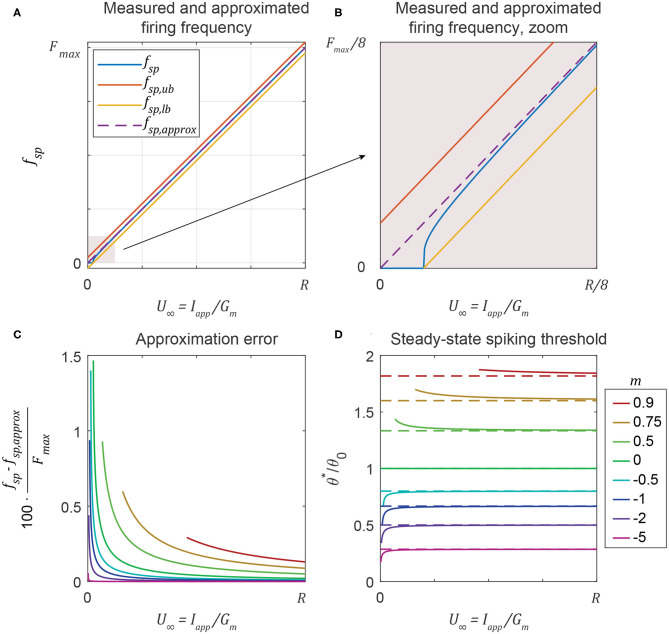
(A) A neuron's spiking frequency fsp is an approximately linear function of the steady-state membrane voltage U∞, staying between the upper bound fsp,ub=(U∞+θ∞*/2)/(τmem·θ∞*) and the lower bound fsp,lb=(U∞-θ∞*/2)/(τmem·θ∞*) (Equation 20). (B) Zooming in shows that the linear approximation is poor at low frequencies. (C) The error between the measured and approximated spiking frequency is a function of both U∞ and m, but stays below 2% in all cases. (D) Even if the spiking threshold can change over time (m ≠ 0), neurons tend to spike at the same threshold no matter the value of U∞. This threshold approaches the explicit approximation in Equation (16) (dashed lines) as U∞ increases.